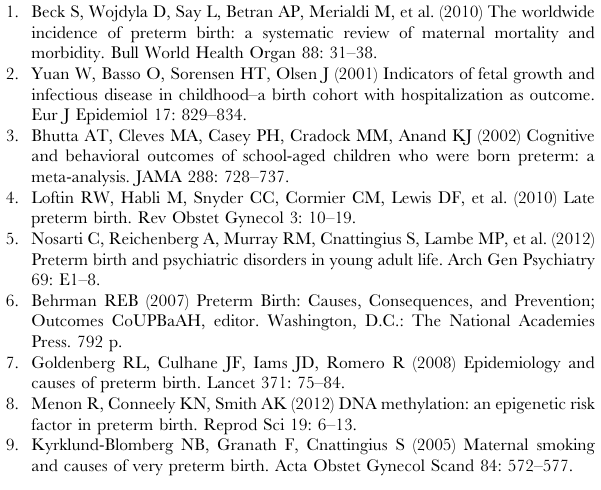
Figure S1 Scatter plots of the unmethylated vs. methyl- ated signals (A versus B) for the five PTB-associated CpG sites that have 1000 Genomes SNPs within the probe. (TIF) Figure S2 Correlation between the t-statics depicting association analysis of CpG sites with PTB (x-axis) compared to GA (y-axis). All CpG sites are depicted whether or not they were associated with the outcome. In order to compare more directly compare the results from analyses of PTB and GA, we reversed the sign of the t-statistics for PTB in this plot. (TIF) Table S1 CpG sites that associate with GA (FDR , .05). (CSV)